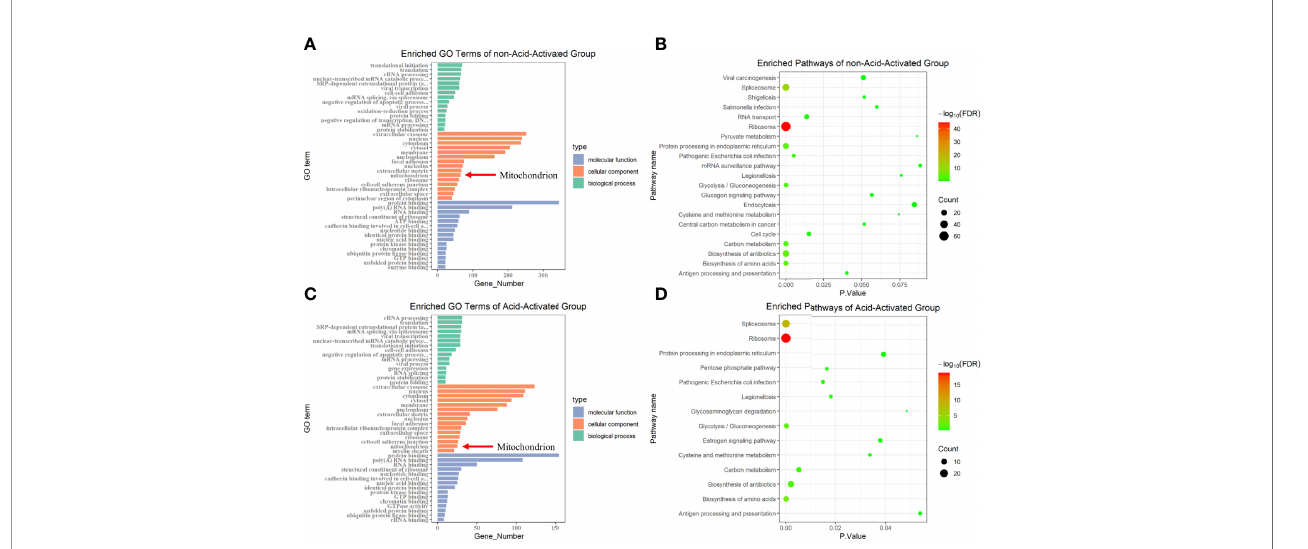
FIGURE 7 | GO terms and KEGG pathway enrichment. Protein identi fi cation results of not-acid-activated and acid-activated groups were analyzed using DAVID Bioinformatics Re-sources and visualized using R. The Gene Ontology (GO) enrichment analysis was displayed in the form of bar graphs (A, C) , and the bubble graphs showed the corresponding enriched pathways (B, D)